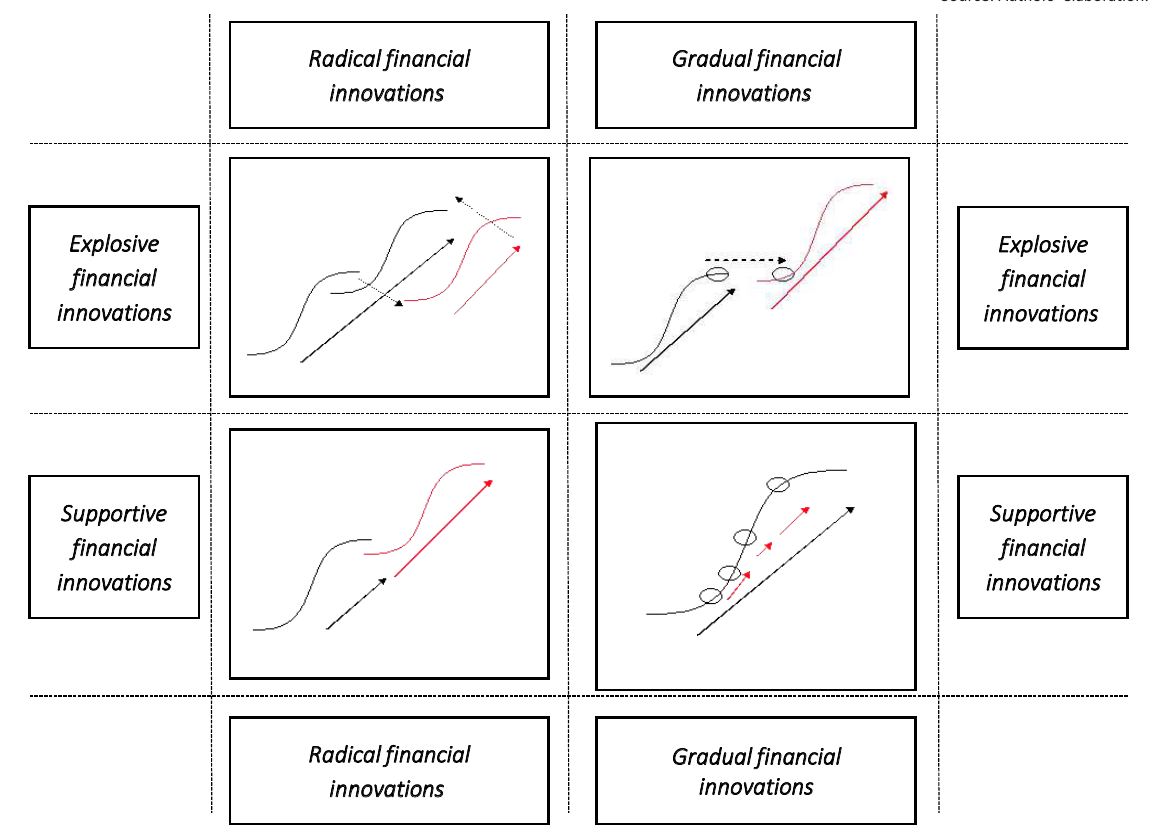
Figure 4. Interpretation of financial innovation matrix